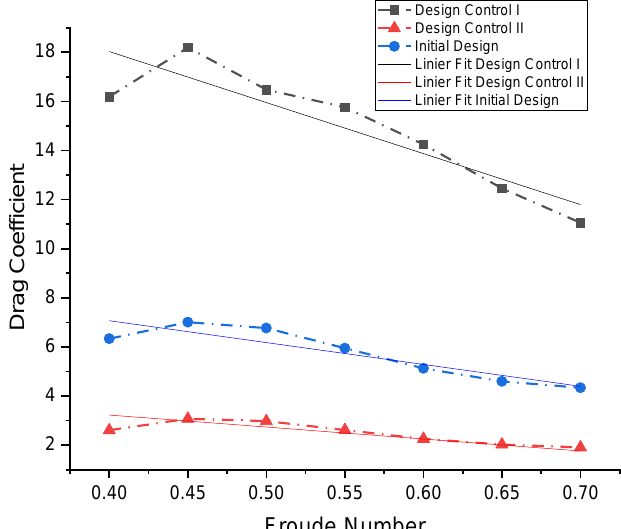
Figure 7. Coefficient drag vs. Froude number of the design model (design control I, design control II, and initial design).